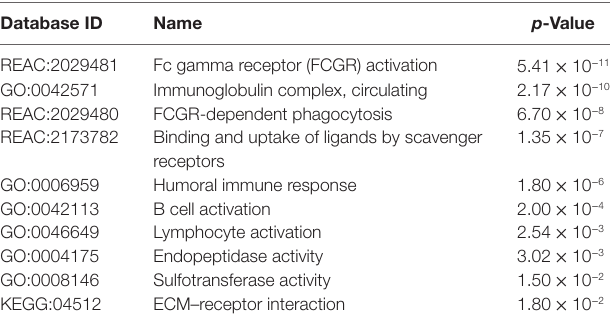
TaBle 2 | Top 10 representative pathway enrichments of differentially expressed genes from public ontology